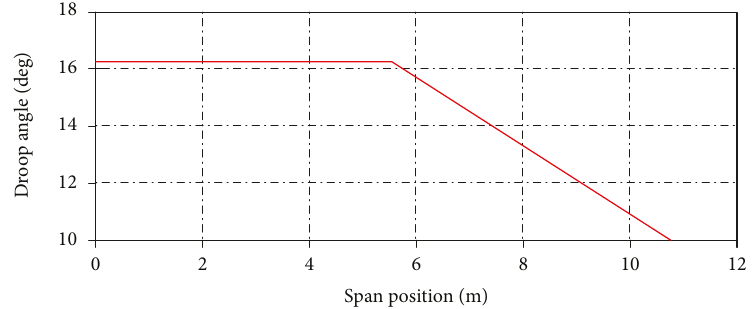
Figure 21: Spanwise droop de fl ection law of the morphing shape number 3.